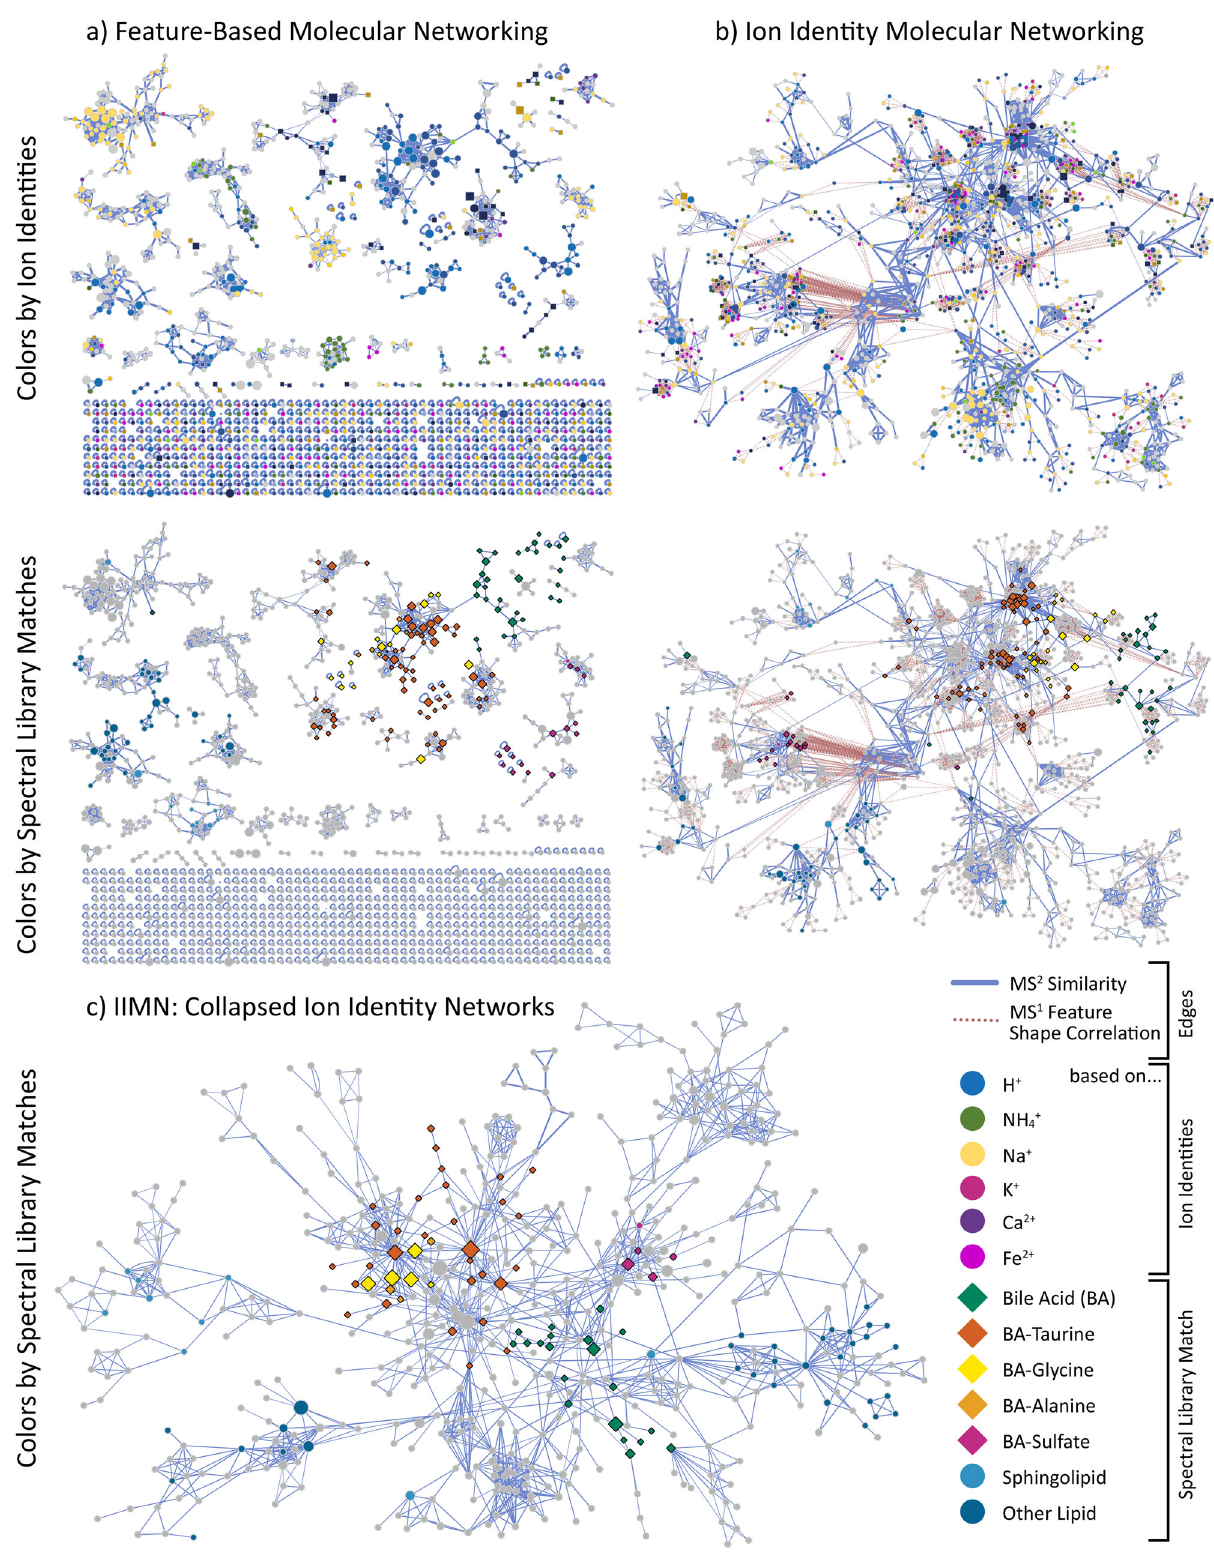
Fig. 5 Comparisons of a subnetwork with matches to bile acids from 88 feces and gall bladder samples of various animals (MSV000084170). This overview compares a the FBMN results to IIMN b before and c after collapsing all ion identity networks into single representative nodes. In the top row, nodes are colorized depending on the adduct that ion identities are based on. In contrast, the lower three networks emphasize nodes with MS 2 spectra that match library spectra of speci fi c compound classes, mainly bile acids and their conjugates. The collapsed network ( c ) reduces the complexity and redundancy of having multiple nodes per compound and only keeps MS 2 spectral similarity